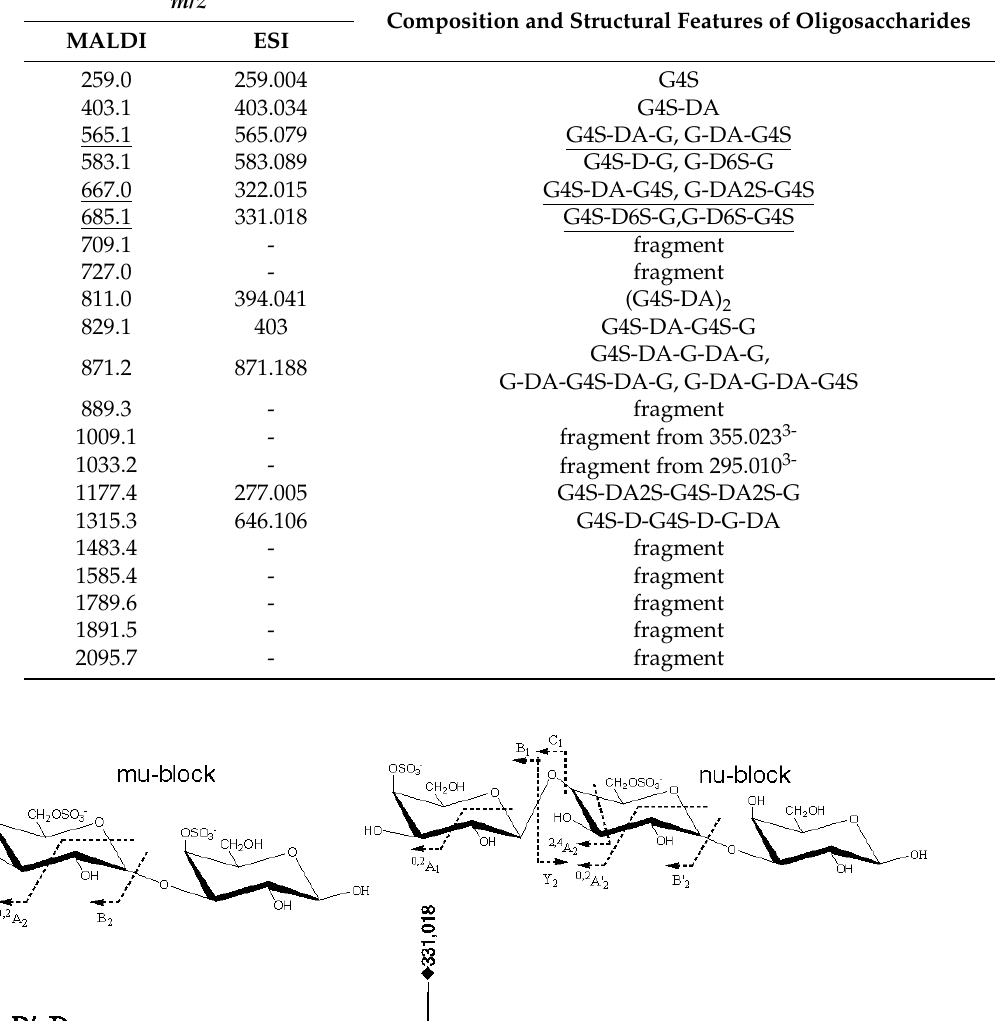
Table 2. Structural features of some oligosaccharides, obtained by mild acid hydrolysis of high- molecular-weight RF/CRG fraction, which was not hydrolyzed by κ -carrageenase from marine bacterium P. carrageenovora.